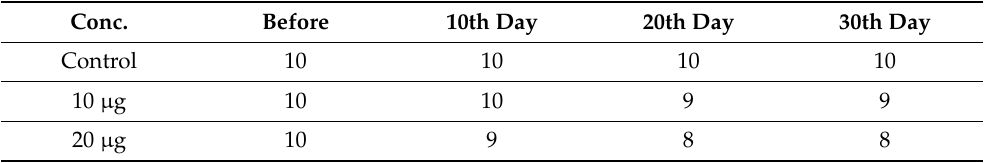
Table 4. Total count of zebrafishes exposed to silver nanoparticles synthesized using Bauhinia purpurea gum. Conc.